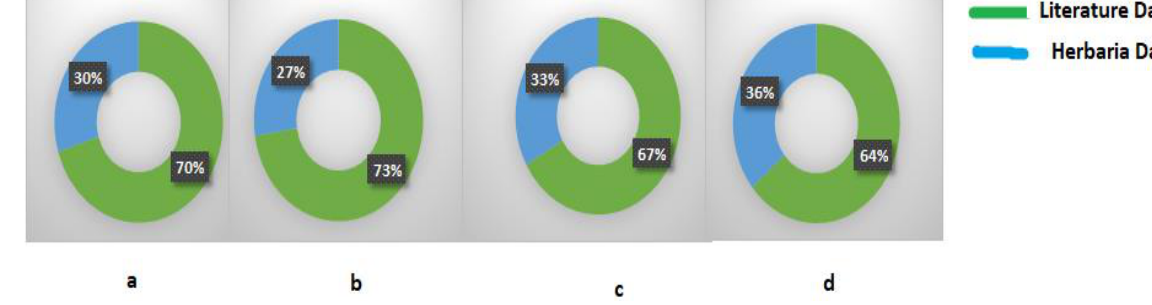
Figure 2. Data of Salix communities. ( a ) S. alba , ( b ) S. fragilis , ( c ) S. purpurea , ( d ) S. triandra .